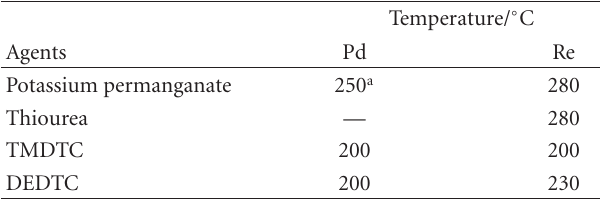
Table 3: Maximum pyrolysis temperatures for the determination of mercury in calibration solutions with the stabilizing agents.